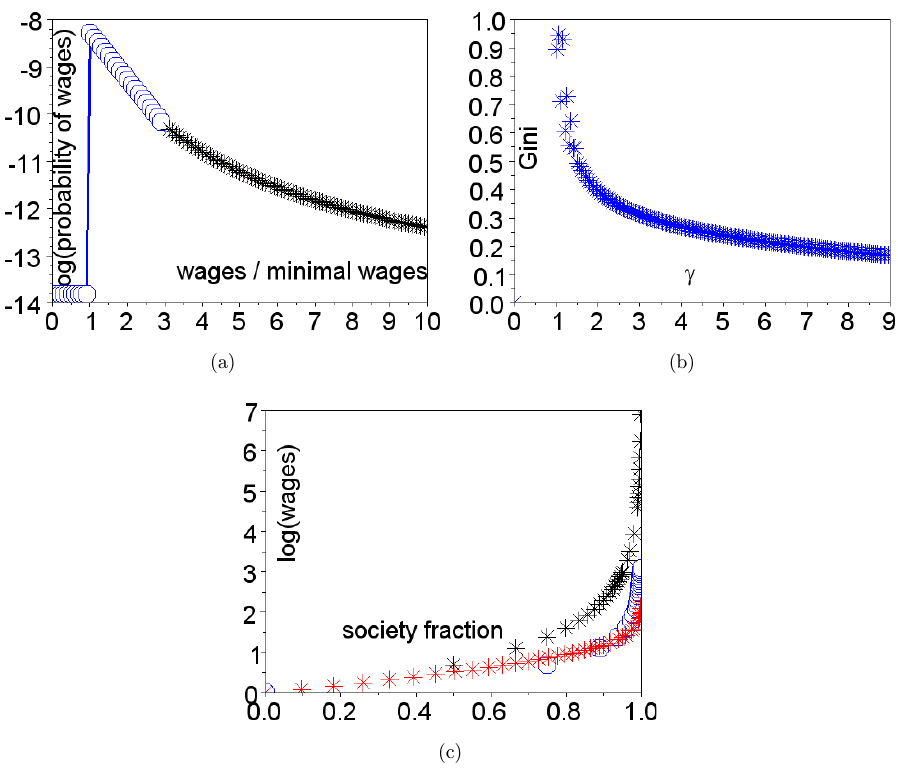
opposition while the poor-group faces di±culties that increase with the income (seen from the various forms of U ). In the ¯rst approximation, v 0 ! 0 . Therefore, in equilibrium, P SC ð c Þ and P DC ð c Þ are the functions in Eq. (5) (the second and third rows, respectively). The correction term depends on the interaction's model there. In Ref. 77, the interaction's model functions yield a net °ow of about 3% of P SC ð c Þ in the interaction area, and that is the circle of about 5% of the society top. This result is valuable since it is showing how the interactions with the top circle can create a smoother f , even in a society where two camps exist.